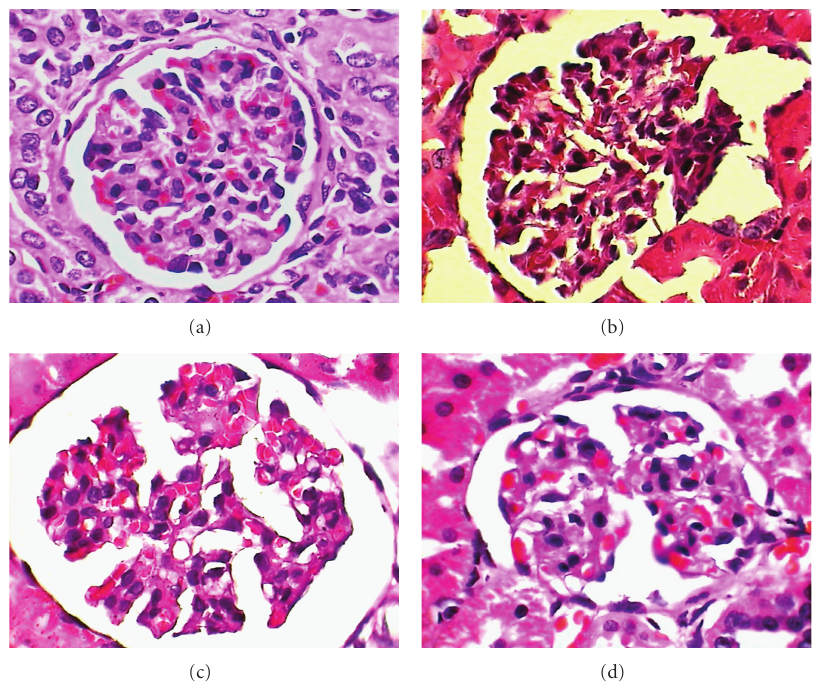
Figure 3: Renal corpuscle micrographs of control (a), malathion ((b) and (c)), and malathion plus α -lipoic acid (d) treated rats. Original magnification